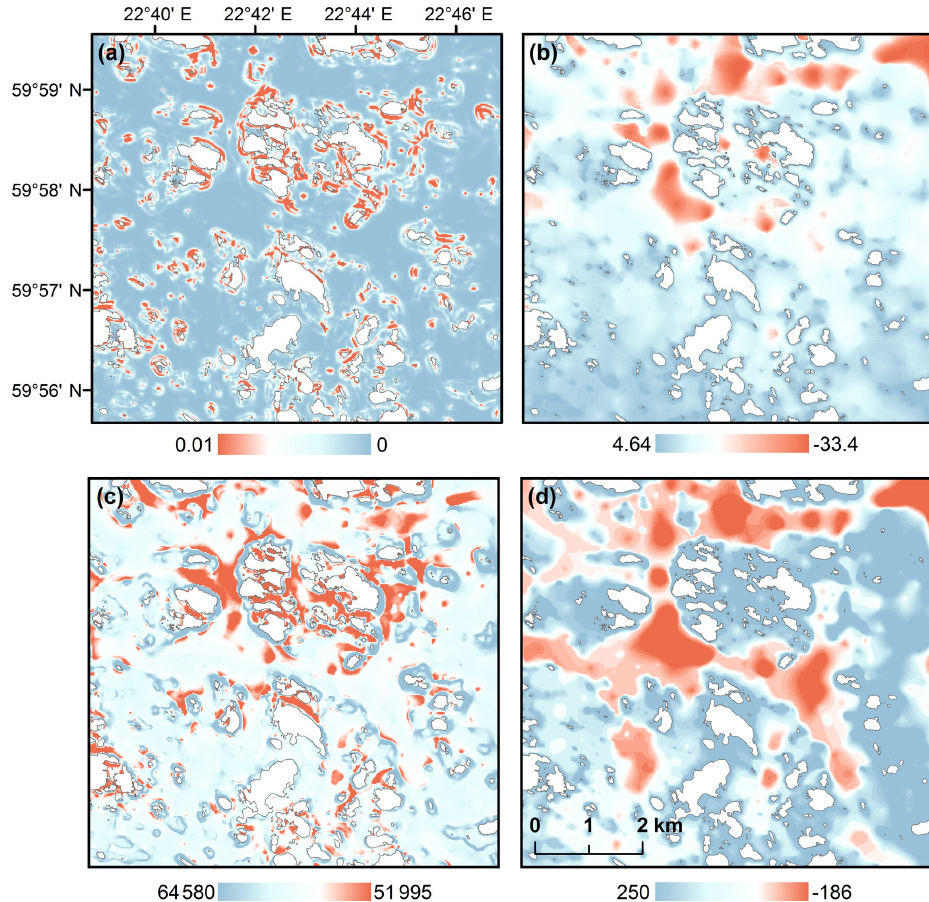
Figure 2. Predictor variables developed for hypoxia ensemble models: (a) vector ruggedness measure (VRM), (b) depth-attenuated wave exposure (SWM(d)), (c) topographic shelter index (TSI) and (d) bathymetric position index (BPI) with a search radius of 2km. Red color represents rugged seafloors (VRM), sheltered areas (SWM(d), TSI) and depressions (BPI2). Islands are shown as